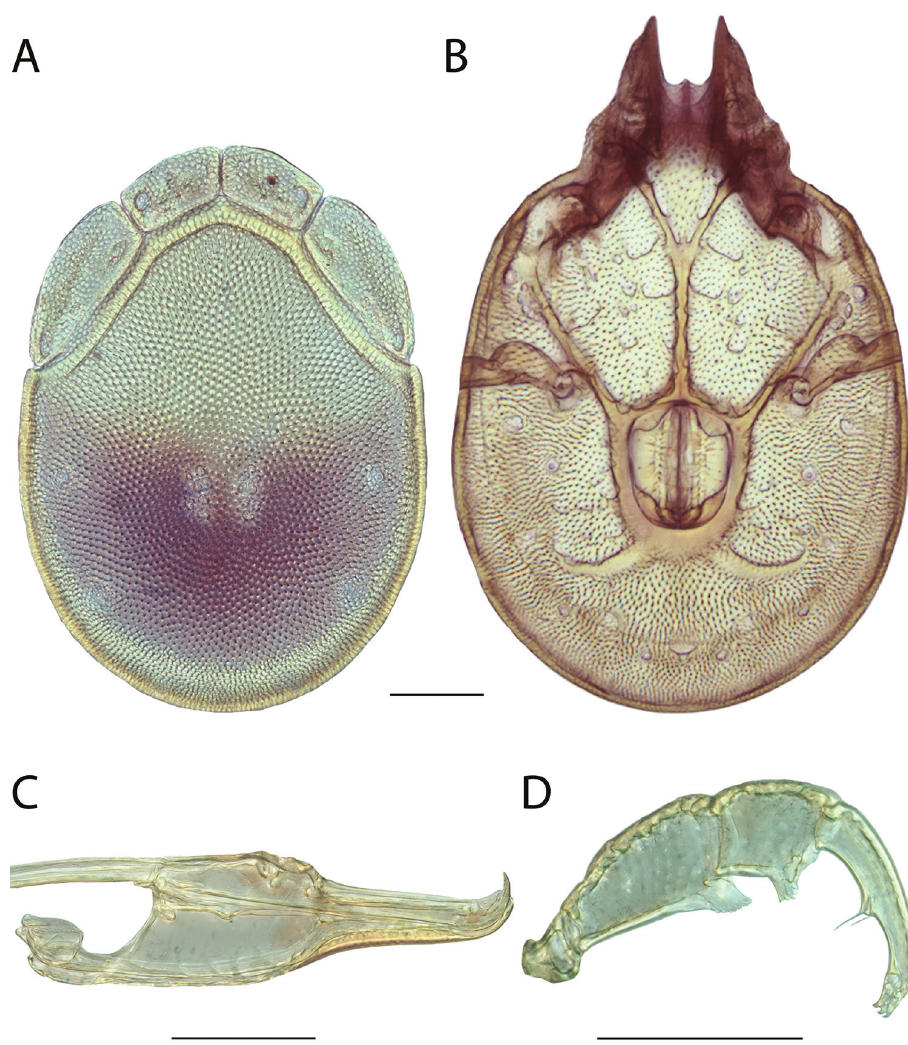
Figure 251. Torrenticola tahoei male: A dorsal plates B venter (legs removed) C subcapitulum D pedipalp (setae not accurately depicted). Scale = 100